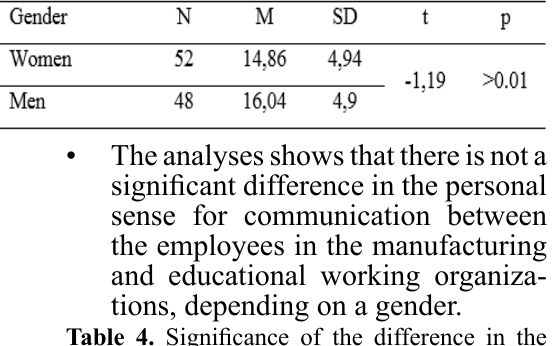
Table 4. Significance of the difference in the personal sense for communication between the employ